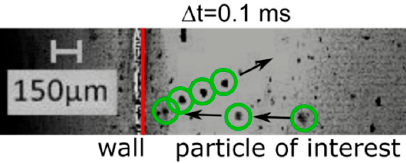
Figure A2. Superimposed picture of a limestone particle, impacting on the steel wall in the impact test bed. The measurement was conducted with 230,000 fps and the chosen time interval between each of the superimposed pictures (green circles) is 0.1 ms.